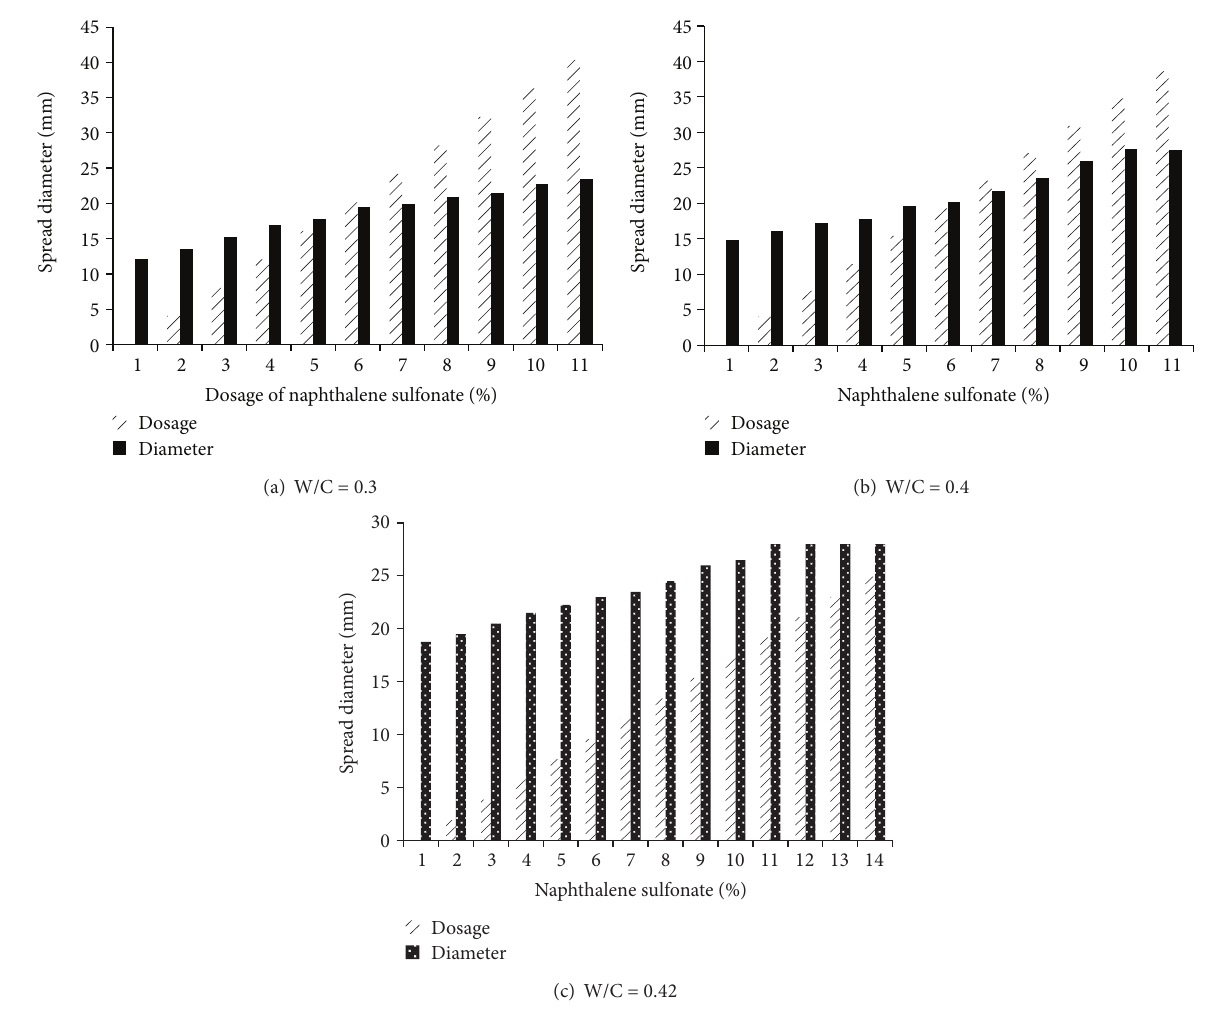
Figure 4: Compatibility of cement with naphthalene sulfonate.